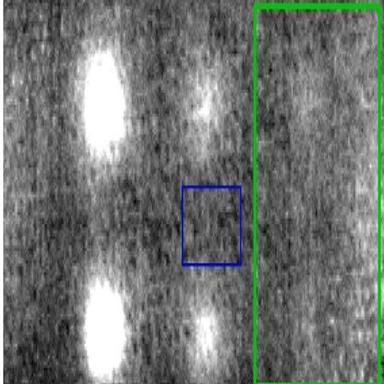
Comparison of excess images when the SNRs of defect C1 and C2 are close to 4 and 3 respectively.